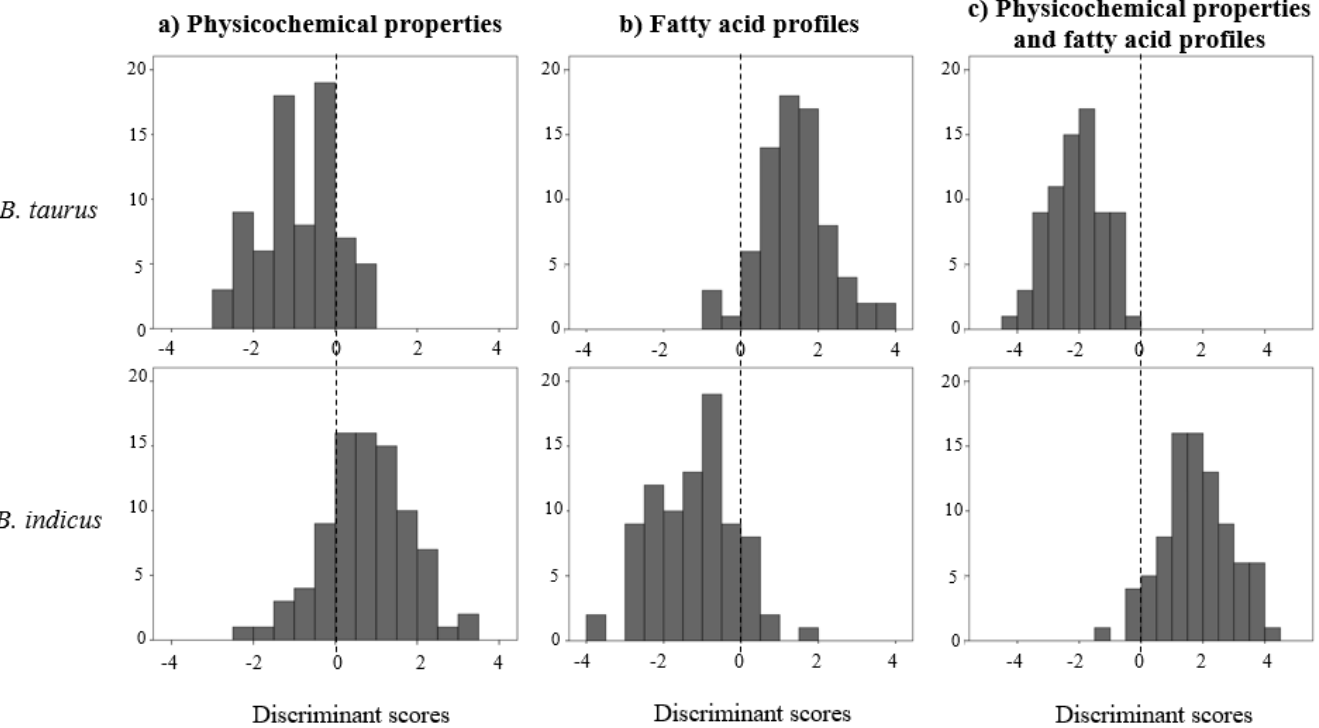
Figure 1. Distribution of discriminant scores in l. thoracis samples from B. taurus and B. indicus bulls based on: ( a ) meat physicochemical properties; ( b ) fatty acid profiles; ( c ) physicochemical properties and fatty acid profiles.